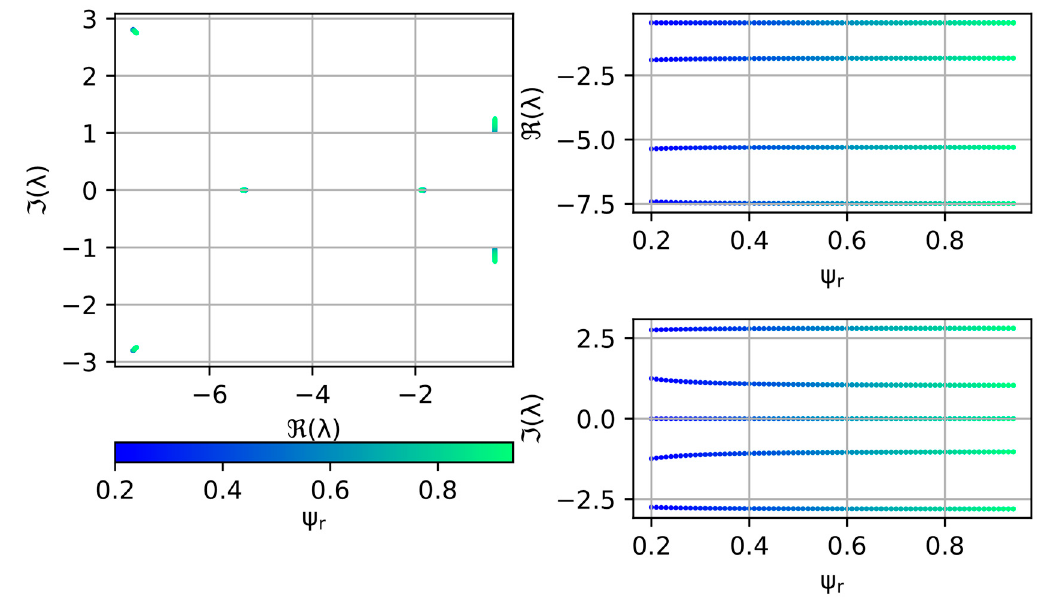
Figure 3. Poles placement of the observer in the function of the rotor flux module under nominal rotor speed and torque T = 0.35.